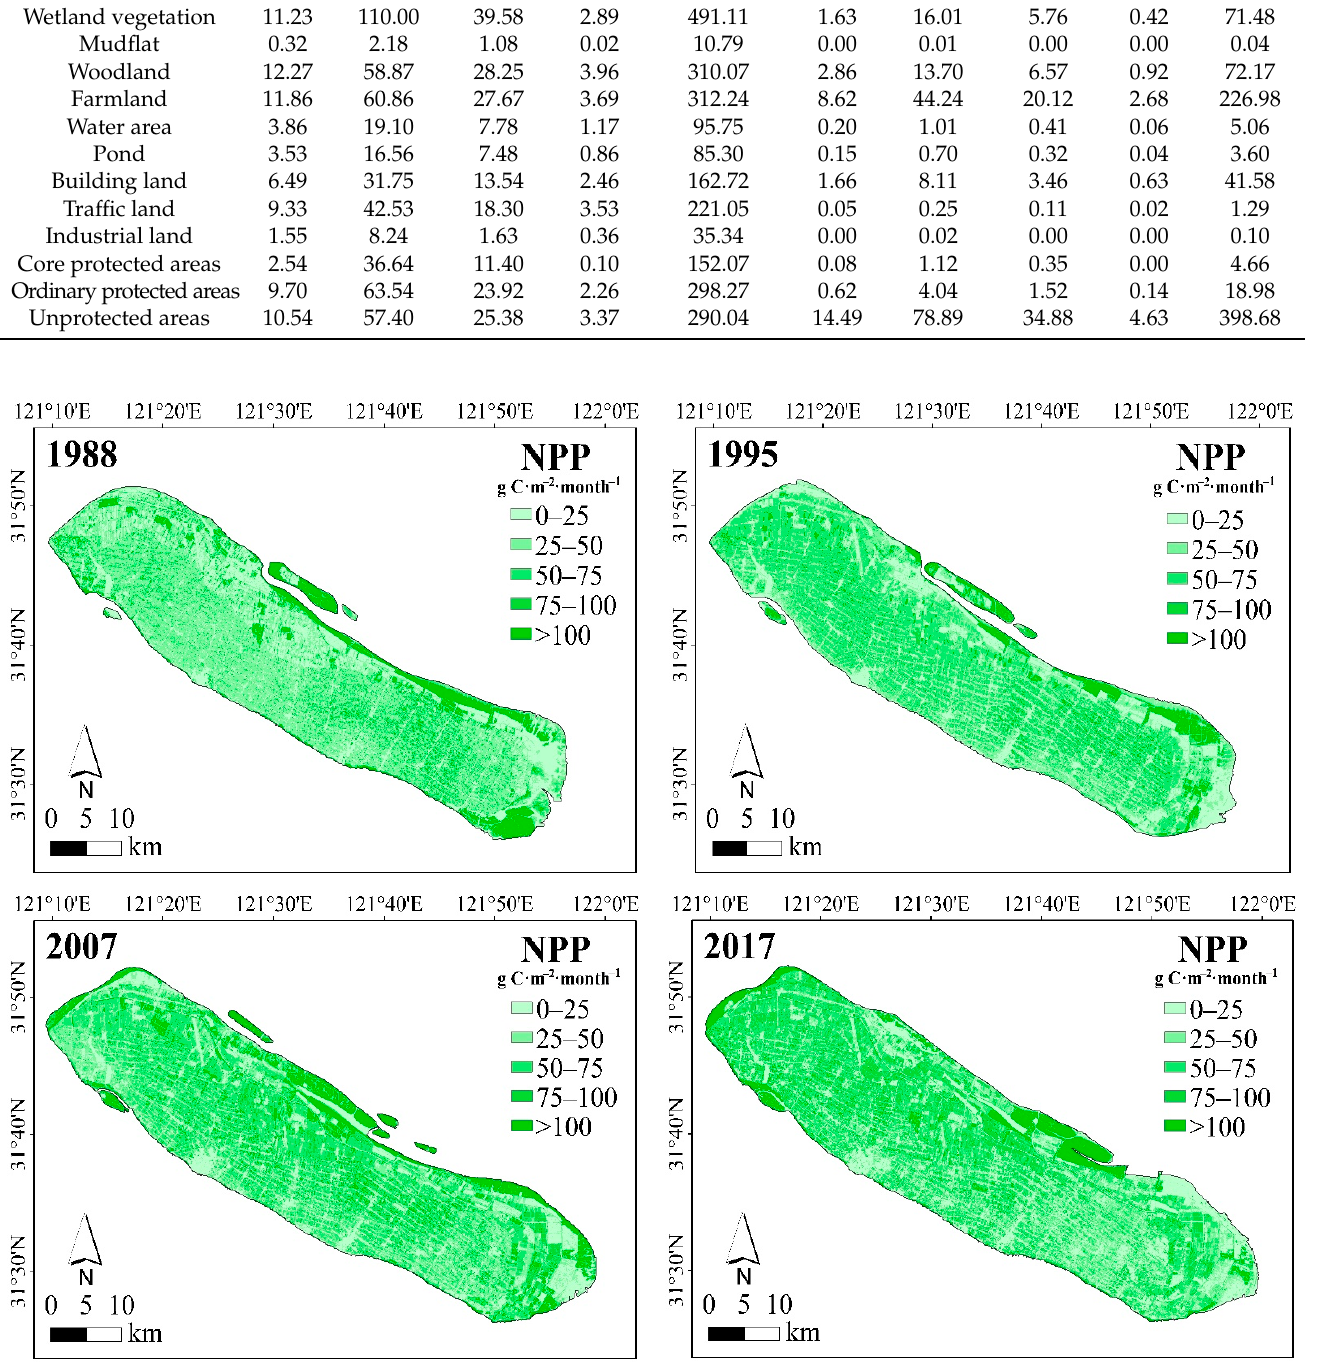
Figure 5. Spatiotemporal characteristics of vegetation NPP in different years.